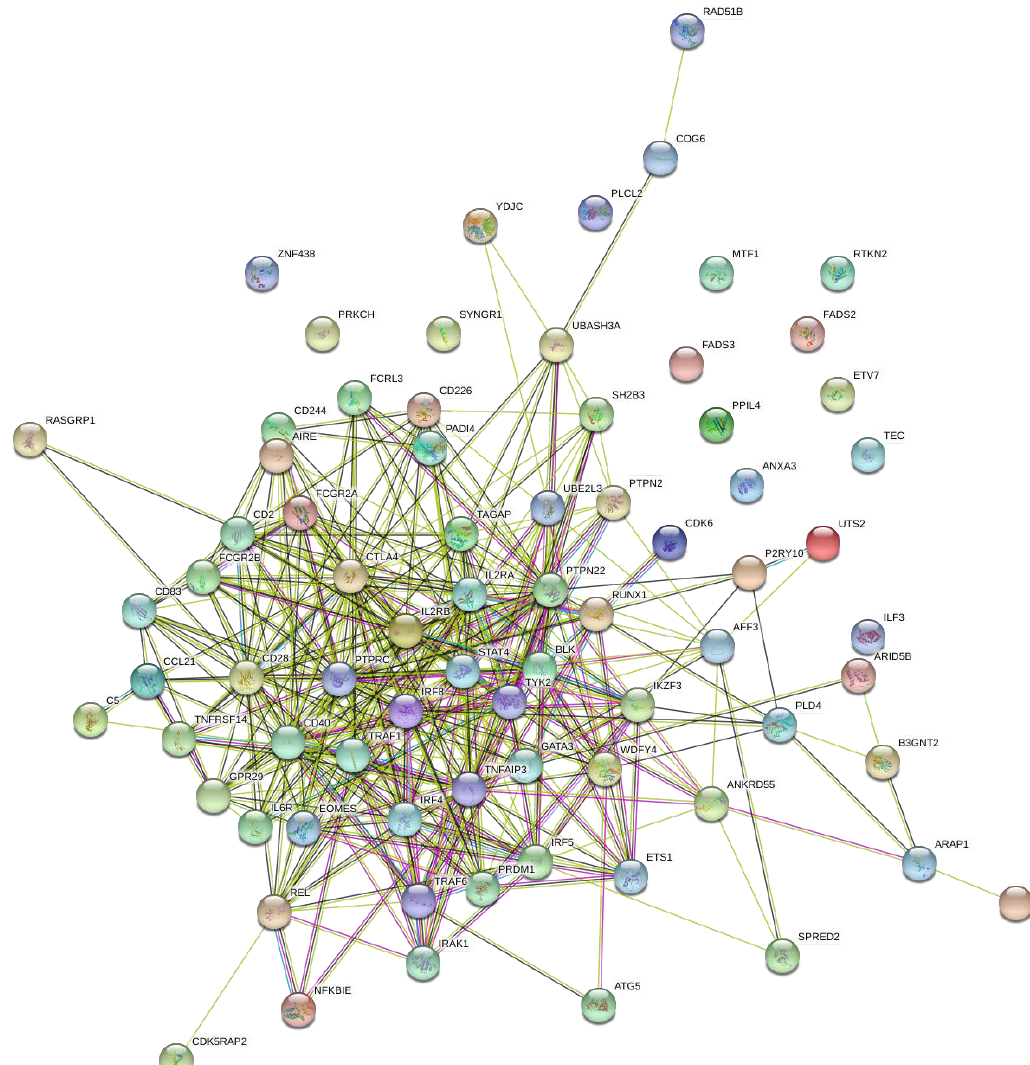
Figure 4. Gene–gene interaction model of 75 RA-associated genes using STRING. This figure was downloaded as a high- quality image file from STRING v11.0 (https://string-db.org/, accessed on 25 February 2021). A guide, representing the different colors in this figure, is provided in Supplementary Figure S2.